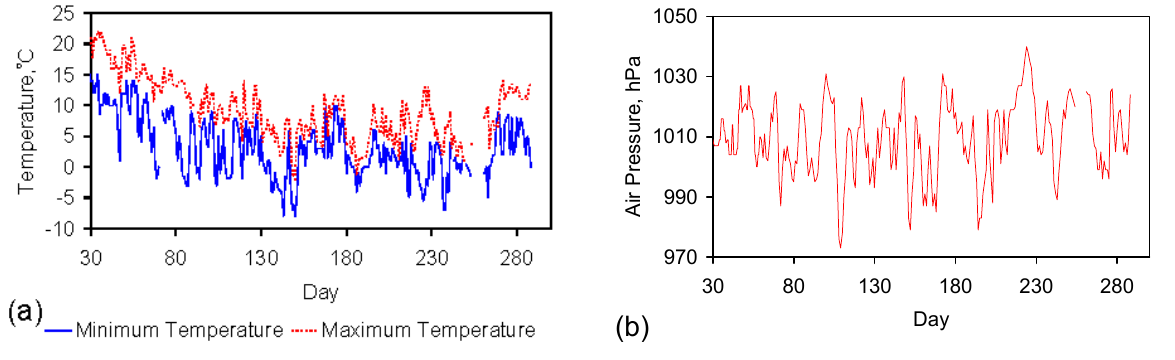
Figure 1. Diabatic operating conditions. ( a ) Temperature; ( b ) Air Pressure. Data